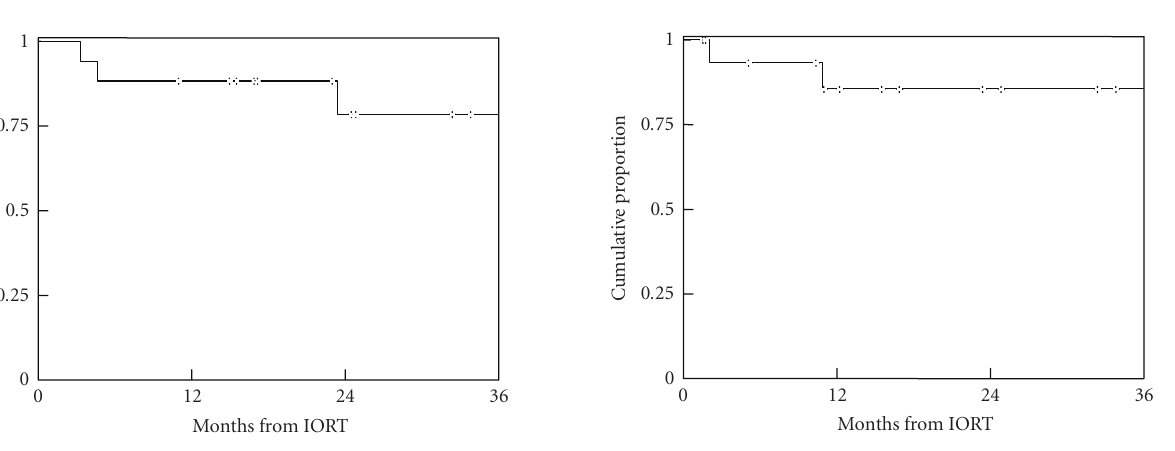
Figure 1: Overall survival. Kaplan-Meier probability estimates. Four of the 17 patients died.